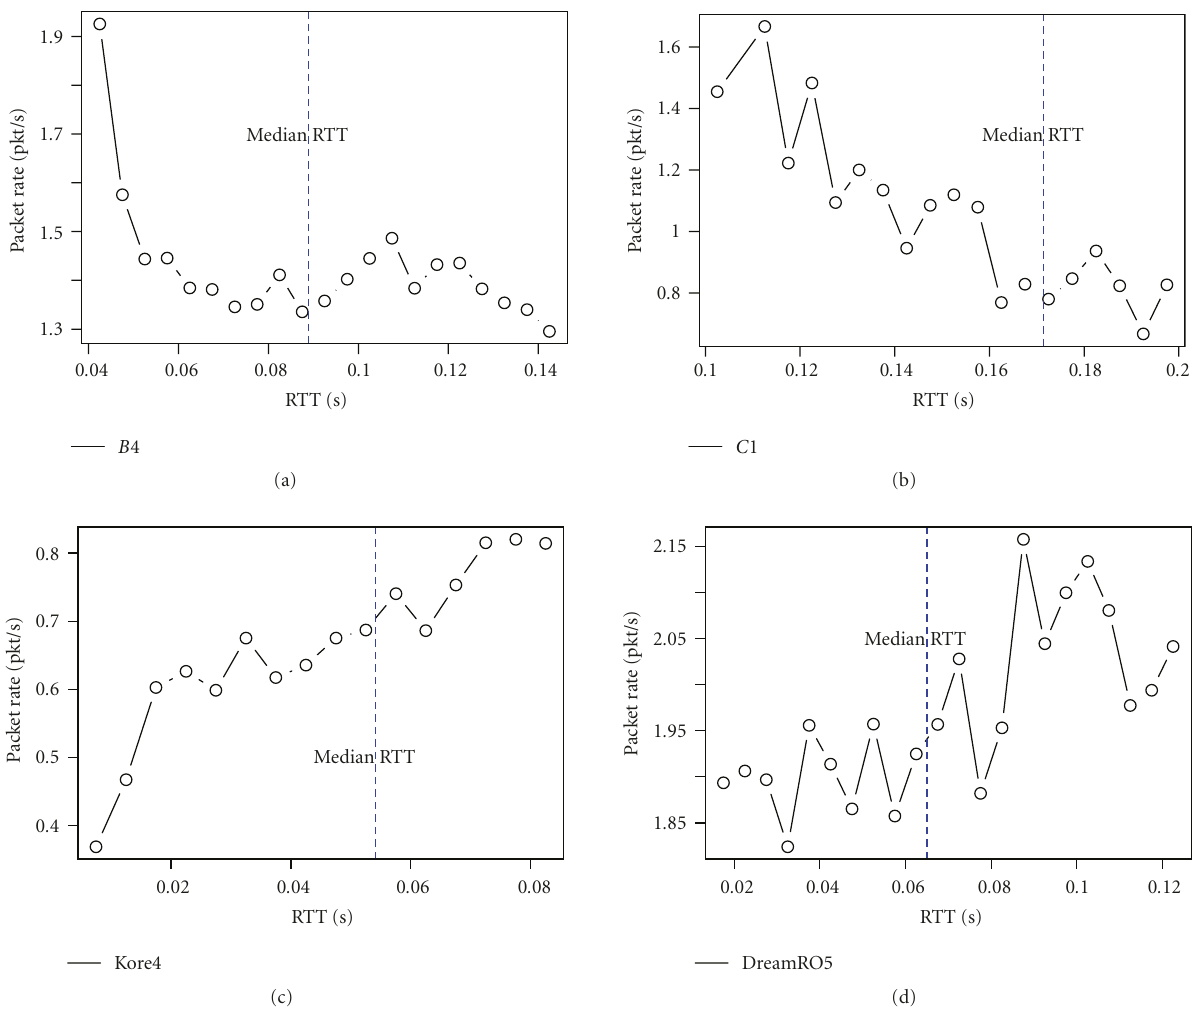
Figure 12: Average packet rates versus round trip times plot. The figures exhibit a downward trend for player traces, and an upward trend for bot